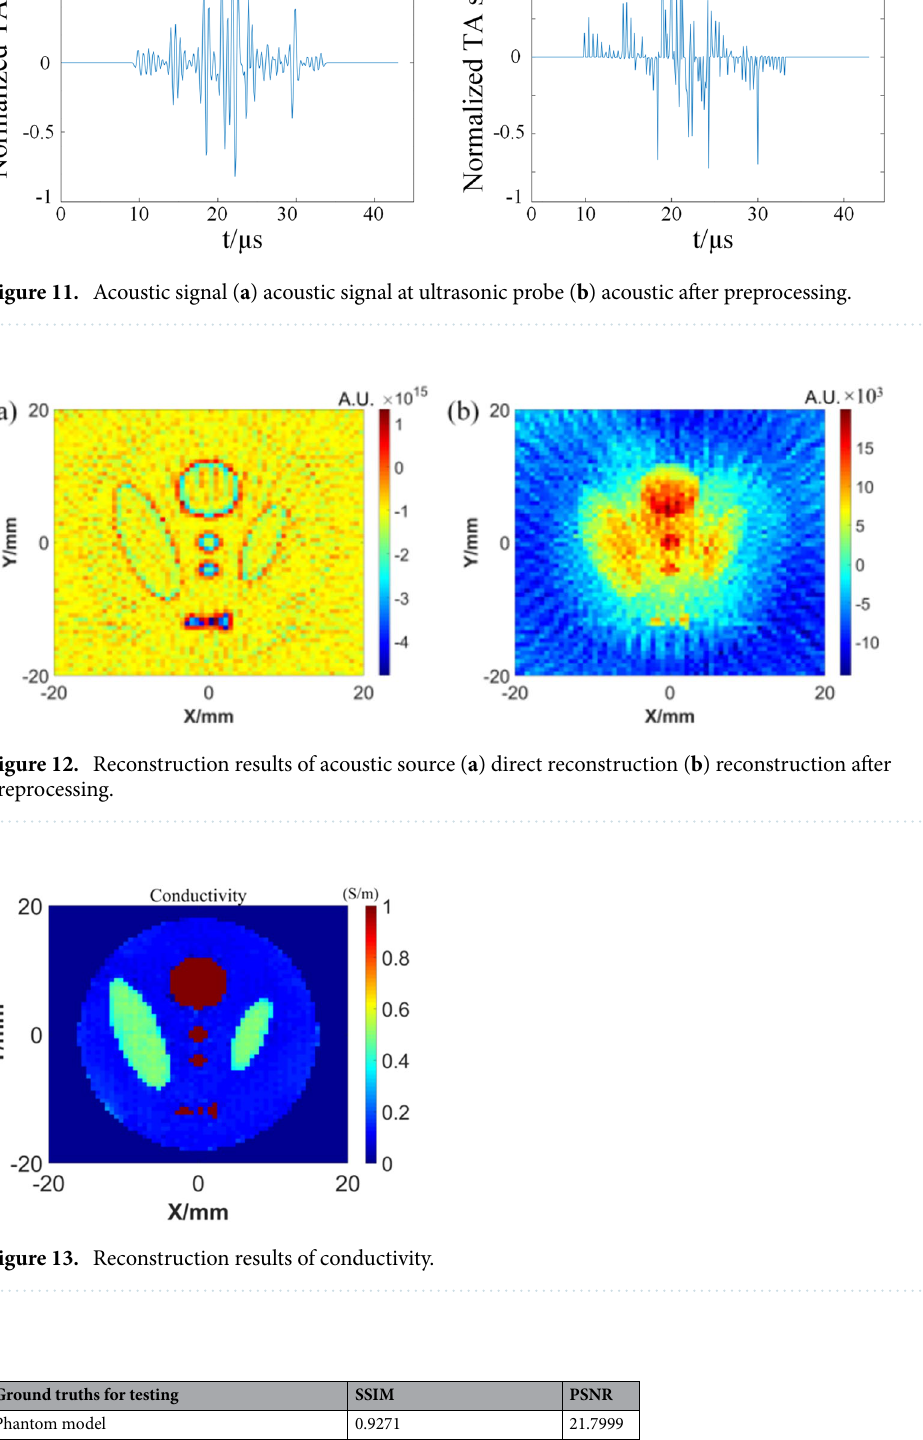
Table 3. Conductivity reconstruction quality of simulation